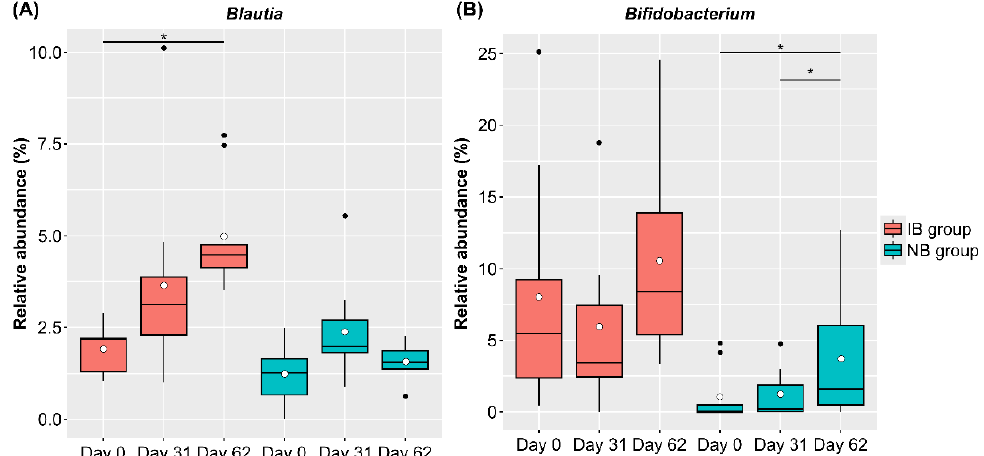
Figure 5. Comparison of dietary habits of individuals in IB (increased Blautia ) and NB (no change in Blautia ) groups. ( A ) Comparison of the frequency of natto intake in the previous month. There was a significant difference ( p < 0.05) between individuals in the IB and NB groups, with those in the IB group consuming natto more frequently than those in the NB group. ( B ) Comparison of the number of fermented foods consumed in the previous month. The following eight categories of fermented foods were considered: pickles, cheese, miso soup, natto, koji food, sake lees food, vinegar, and others. There was a significant difference ( p < 0.01) between the IB and NB groups, with more fermented foods consumed in the IB group than in the NB group.